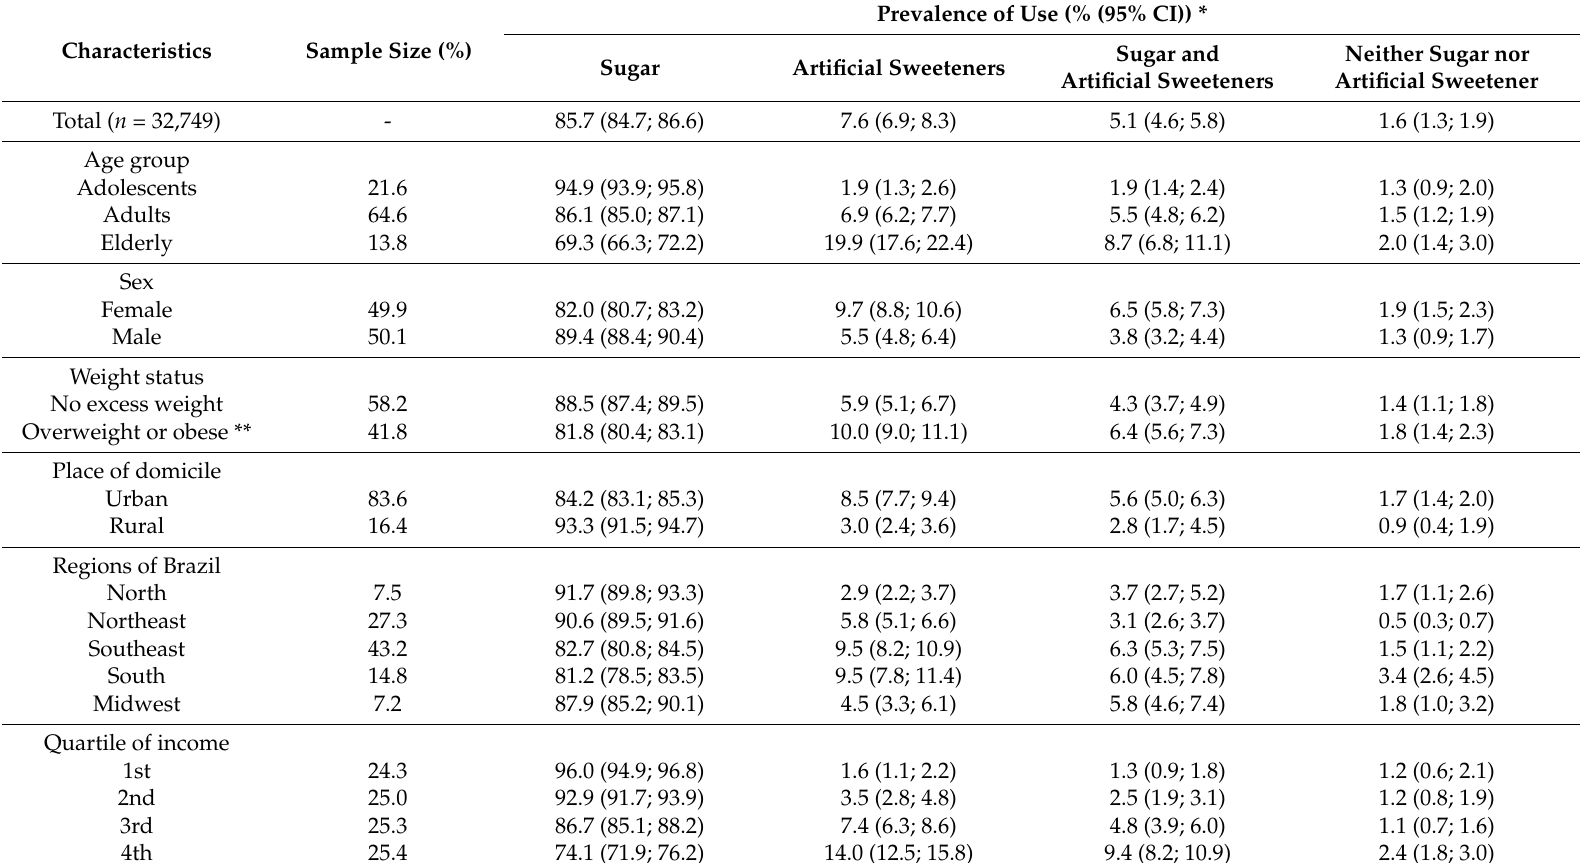
Table 1. Sample size and weighted prevalence of sweetener use. Brazil, National Dietary Survey